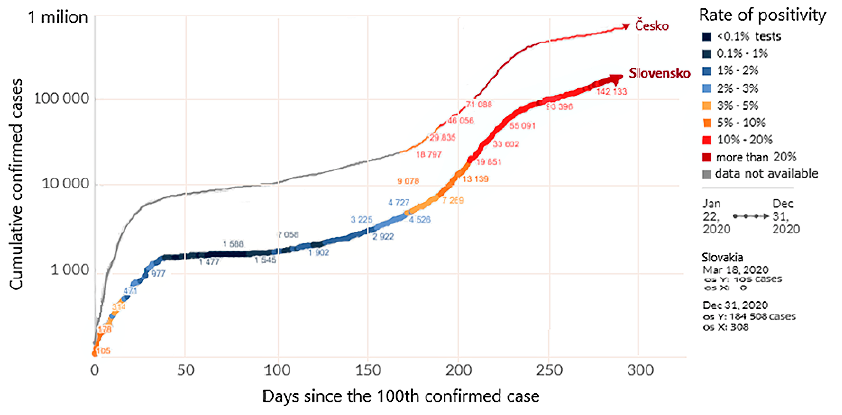
Figure 2. Changes in the rate of confirmed cases of Covid-19 Source: Johns Hopkins University (2021), Our World in Data